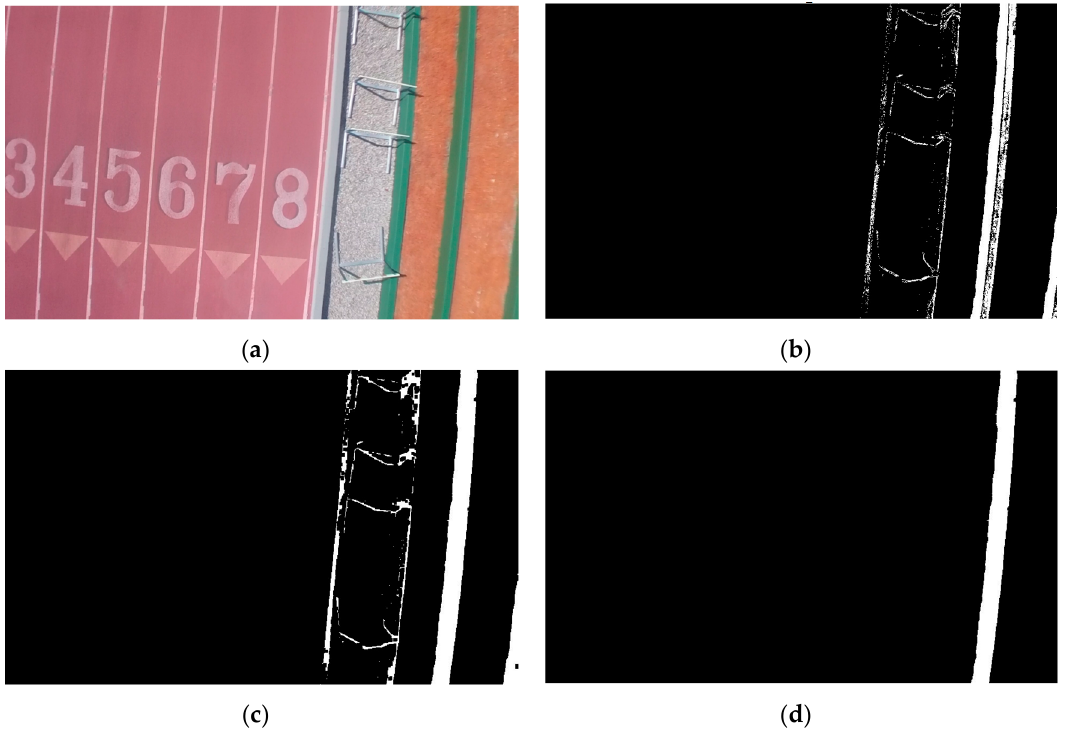
Figure 11. Example image processing for the rectilinear motion evaluation. ( a ) Original image of running track; ( b ) Segmented image; ( c ) Filling hole operation; ( d ) Extraction of line.